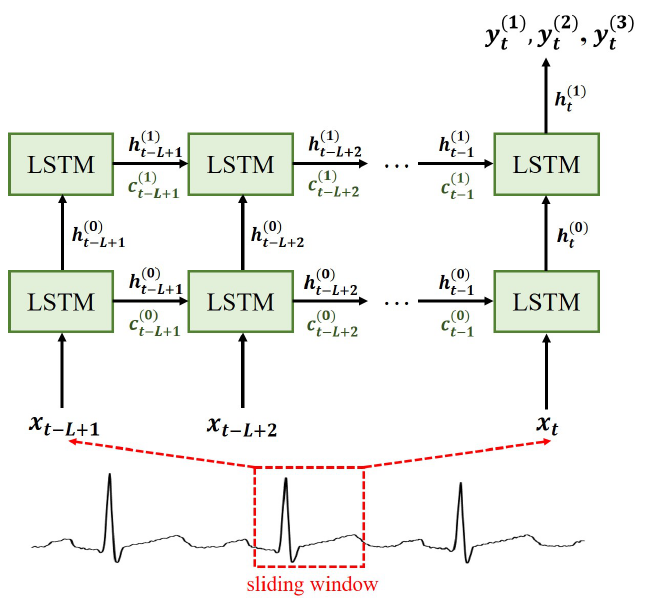
Figure 4. System architecture of the proposed VCG